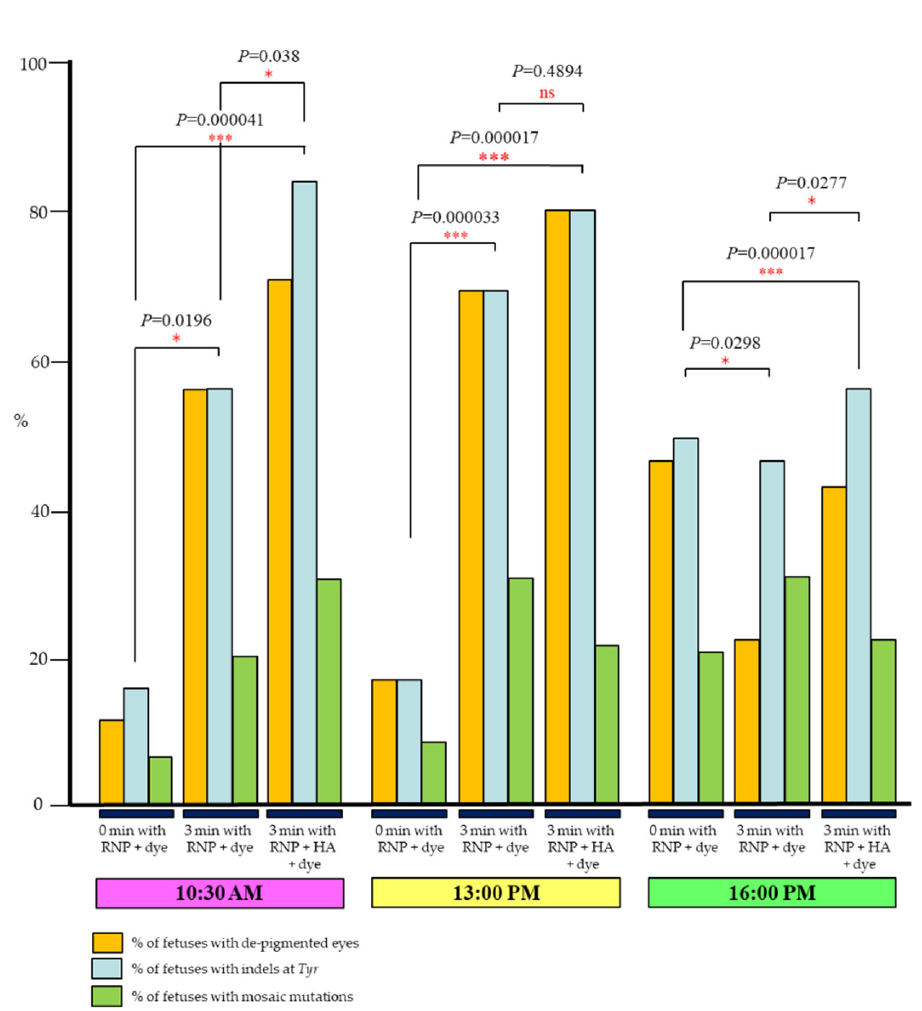
Figure 2. Summary of the experiments using i -GONAD-mediated genome editing targeting Tyr as shown in Figure 1A. The detailed data are shown in Table S1. i -GONAD was performed at various times (10:30 a.m., 13:00 p.m. and 16:00 p.m.) in the day (when vaginal plugs were first discerned) using different conditions (in vivo electroporation (EP) immediately (0 min) after intraoviductal instillation of ribonucleoprotein (RNP) + Fast Green FCF (dye), which is defined as “0 min with RNP + dye”, in vivo EP 3 min after intraoviductal instillation of RNP + dye, which is defined as “3 min with RNP + dye” or in vivo EP 3 min after intraoviductal instillation of RNP + hyaluronidase (HA) + dye, which is defined as “3 min with RNP + HA + dye”. At Day 12.5 of pregnancy, mid-gestational fetuses are dissected from the i- GONAD-treated females, in which Tyr locus had been targeted. Percent of fetuses showing de-pigmented eyes (filled orange), idels at Tyr (filled blue) and mosaic mutations (filled green) are shown as graphs. Statistical analysis was performed using chi-square test; * p < 0.05; *** p < 0.001; ns, not significant. We next performed whether in vivo EP left for three min after intraoviductal injection with RNP + HA + dye at Day 0.5 of pregnancy (13:00 p.m.) has the ability to disrupt another endogenous locus (which is called “Gene A”; Figure 1B) with a good efficiency. We compared the genome editing efficiency in the F0 pups (derived from B6 females) obtained after i -GONAD under the conditions, 0 min with RNP + dye or 3 min with RNP + HA + dye on 13:00 p.m. The results are shown in Table 1. As expected, the latter treatment exhibited better genome-editing performance than the former treatment (46% (6/13) vs. 23% (3/13), p =